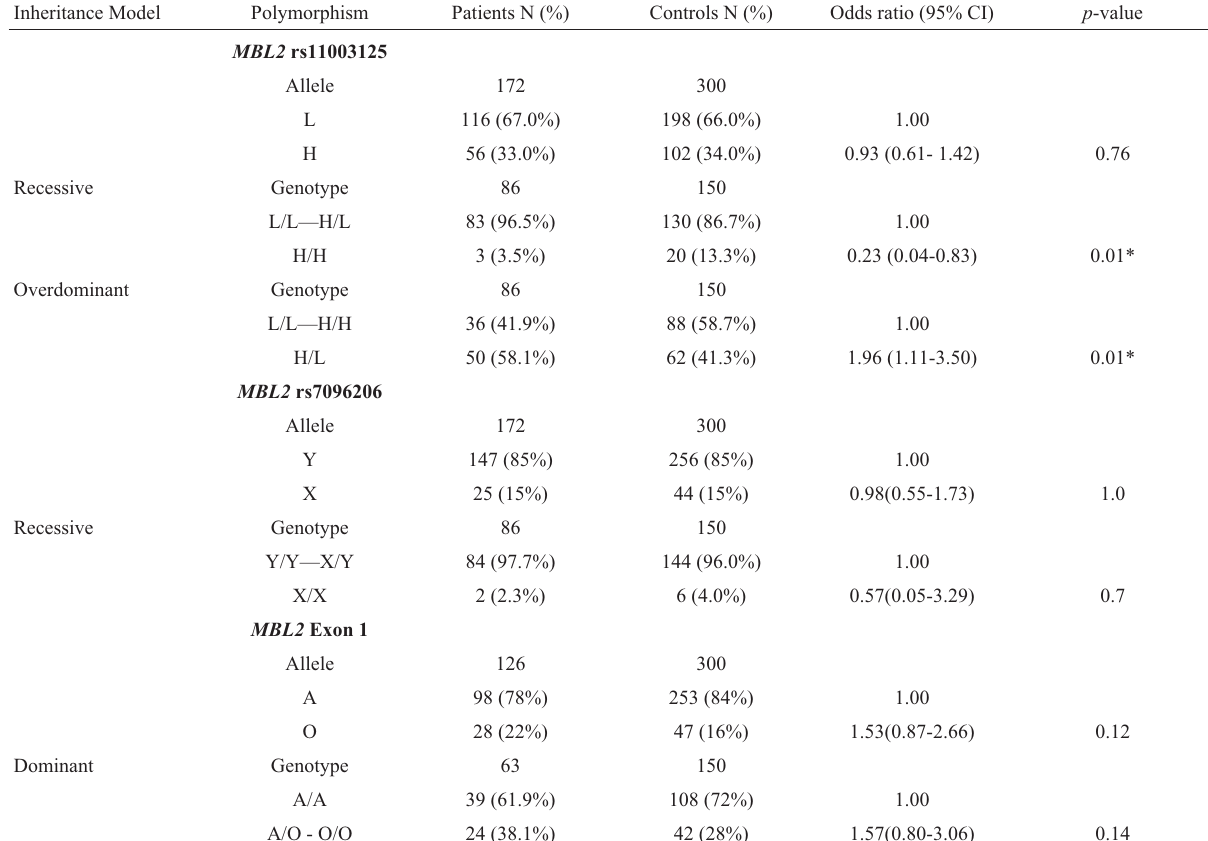
Table 4 - Genotype and allele distribution of MBL2 gene polymorphisms in TS and controls group. Inheritance